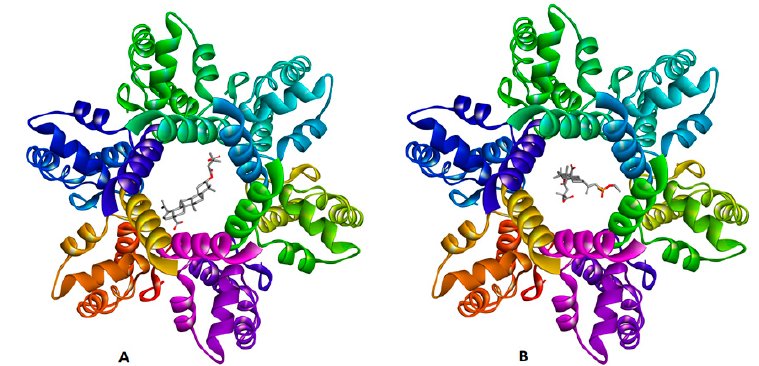
Figure 5. Docking poses of HIV-1 capsid (CA) C-terminal domain (CTD)-spacer peptide 1 (SP1) protein complexes with BVM ( A ) and 14a ( B ) from a top view.